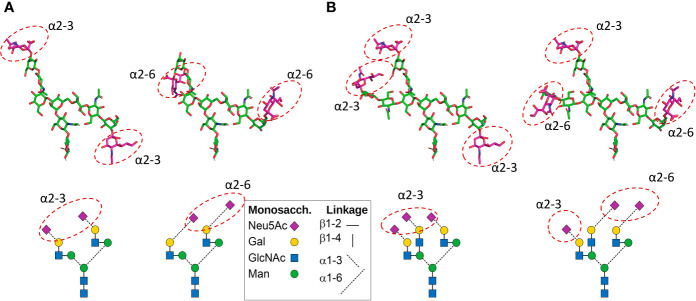
Positions of Neu5Ac residues in CHO cell-produced recombinant FSH (A) and pituitary FSH glycans (B). Top: 3D models show neutral monosaccharide carbon atoms in green. The sialic acid residue carbon atoms are shown in magenta, like the symbols in the glycan diagrams below each 3D model. The 3D models were built using the current Glycam web tool (http://glycam.org). (A) In Gonal-F® and Bemfola®, >90% of glycans at αAsn52, αAsn78, and βAsn24 are biantennary with two α2–3 linked Neu5Ac residues (the only significant variant has one Neu5Ac instead of two). The position of potential α2–6 Neu5Ac residues (which are absent in CHO cell-produced recombinant FSH preparations) in the biantennary structure shown at the right is also shown. (B) In pituitary FSH the most abundant types of glycan are the triantennary type. Two alternatives exist (11): a. all three Neu5Ac residues can be linked α2–3; b. alternatively, there can be 2 linked α2–6 and one linked α2–3. The one α2–3 linked Neu5Ac on the Galβ1-4GlcNAcβ1-2Manα1-3 branch (right) was arbitrarily placed. A diagram of each glycan is shown below to help ID the glycans. Figure courtesy of Dr. George R. Bousfield, Department of Biological Sciences, Wichita State University, Wichita, KS, USA.